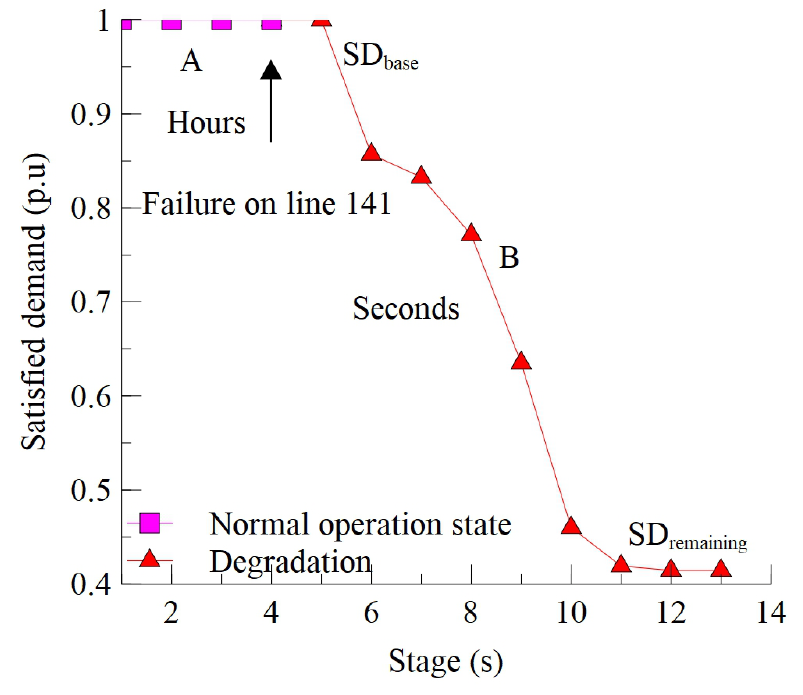
Figure 6. Degradation of the IEEE 118-bus test network. Results obtained using Algorithm